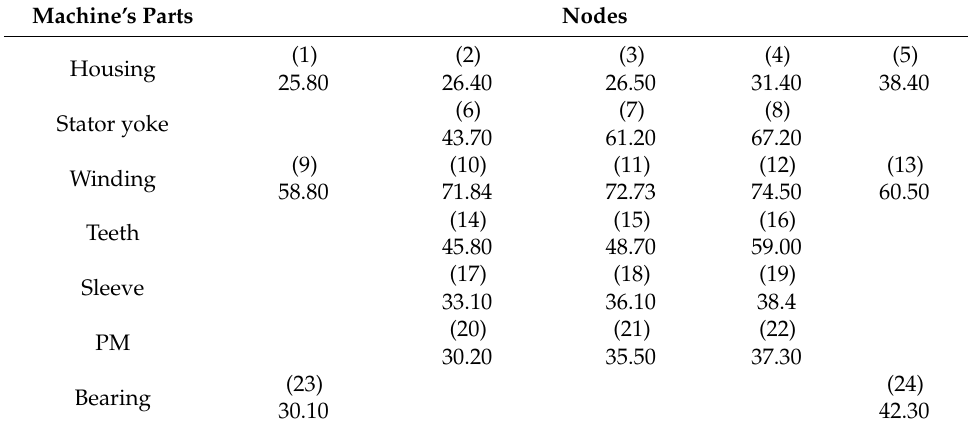
Table 9. An estimated temperature rise of A4 model HSPMSM after sensitivity